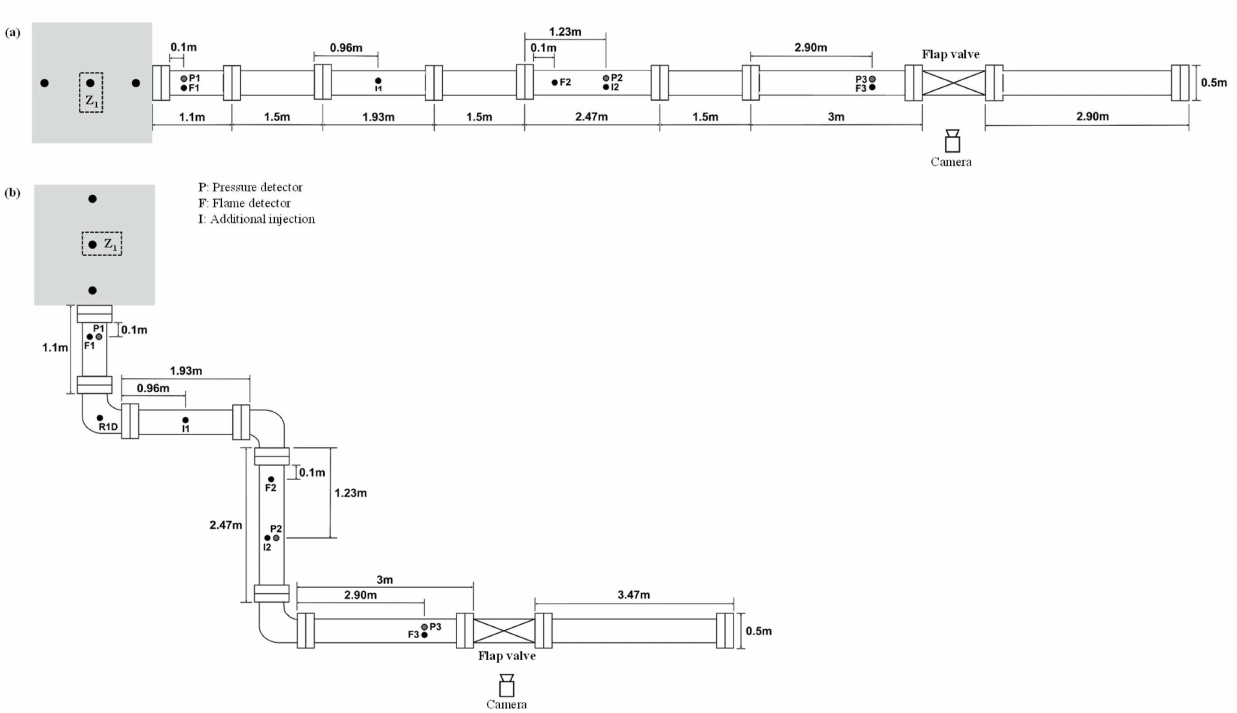
Figure 3. Technical drawing of duct configurations used: ( a ) straight duct, ( b ) including 90 ◦